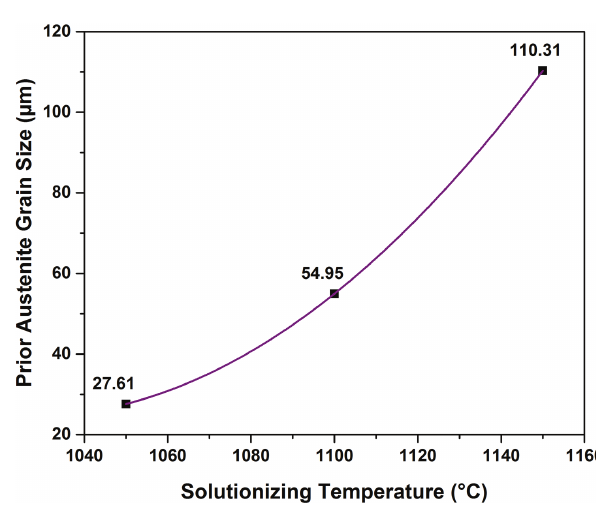
Figure 3: Effect of solutionizing temperature on grain size of T92 steel test